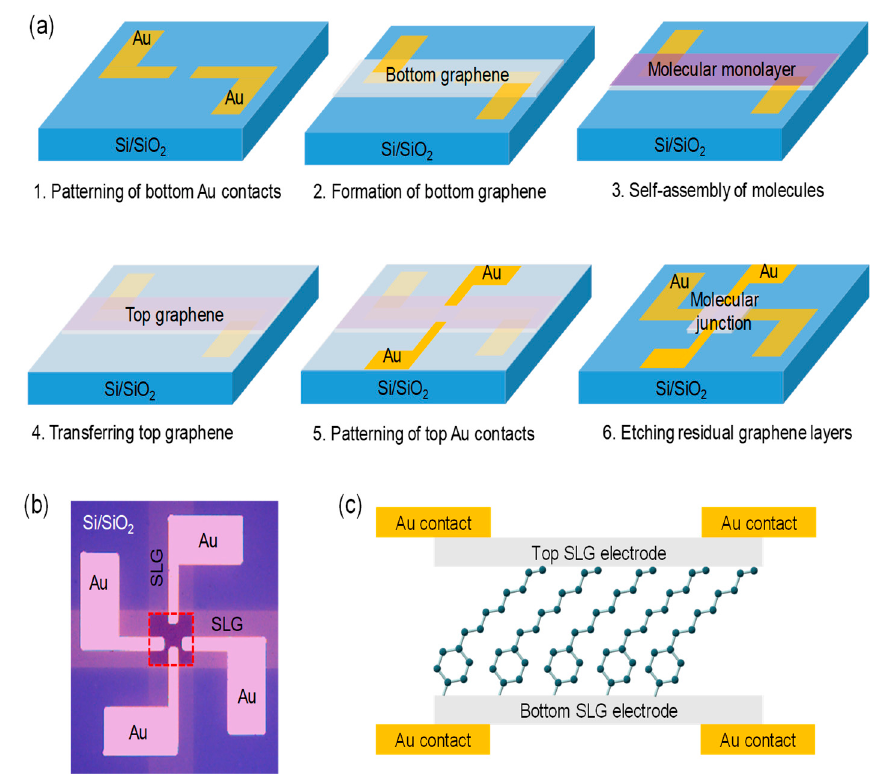
Figure 1. ( a ) Illustration of the fabrication process (step 1 to step 6) of the vertically stacked graphene/arylalkane/graphene device. ( b ) Optical image of a complete device. Red dashed square denotes the area of an active junction, which was estimated to be 250 × 250 μ m 2 . ( c ) Schematic of the device structure in a cross-sectional view. The component molecule in the junction is C8.